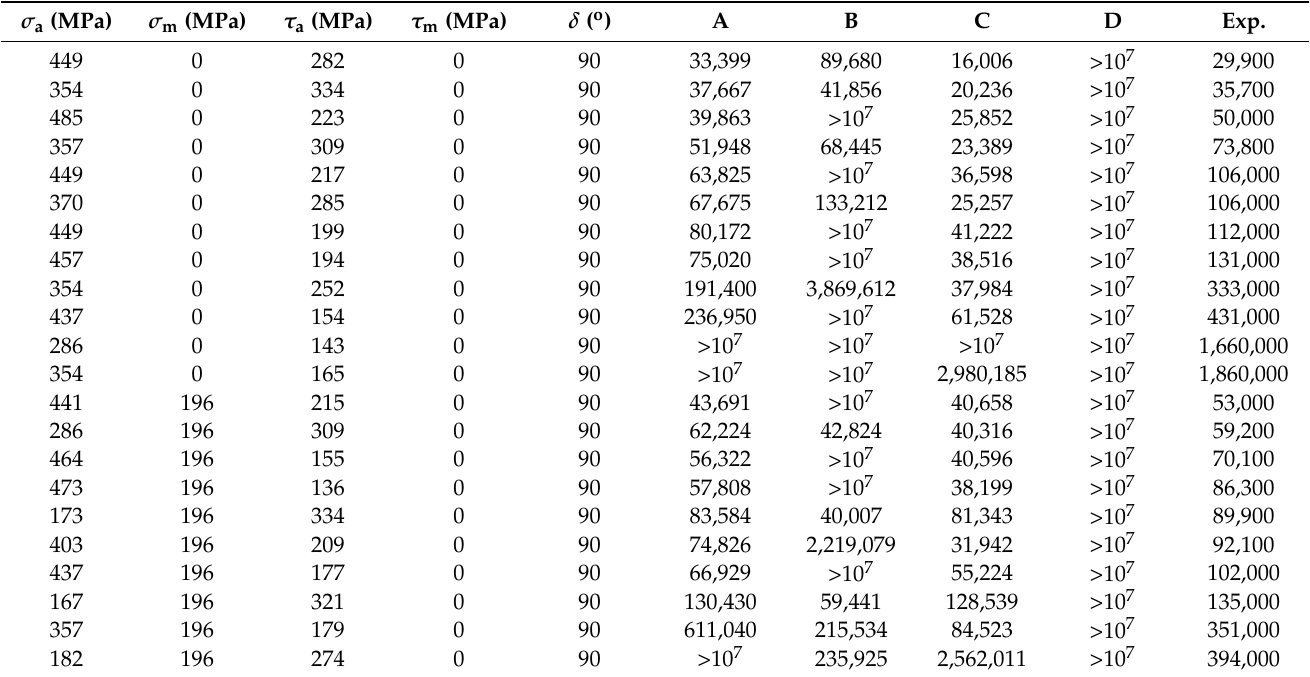
Table 2. Fatigue strength and material parameters of S–N curvilinear equation of carbon structural steel SM45C